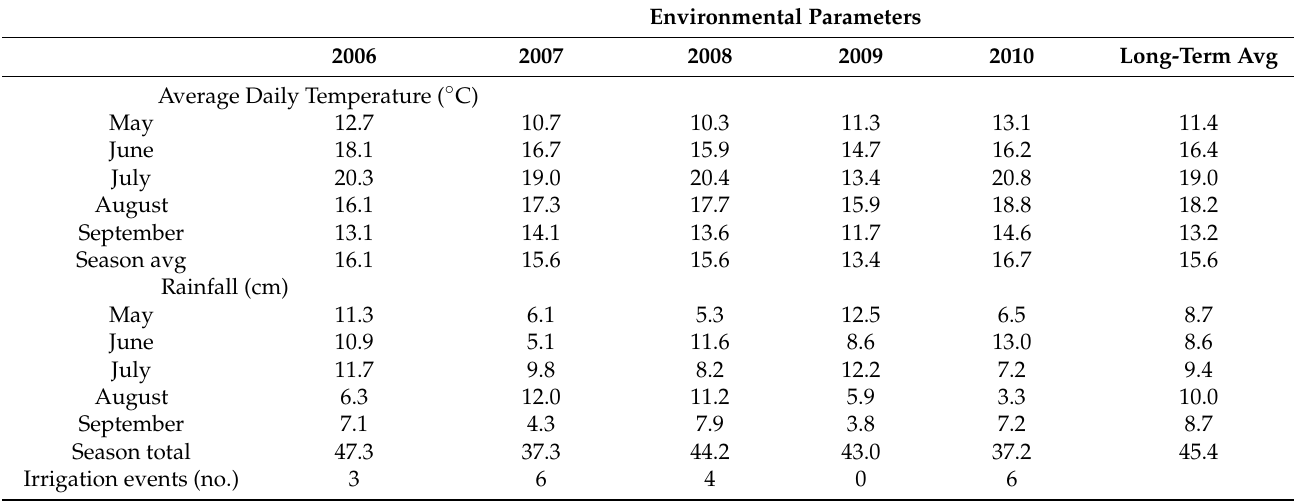
Table 2. Average daily temperature, total rainfall, and number of irrigation events for the months of May through September at the Presque Isle research site for 2006 to 2010 compared with long-term (30 year) average